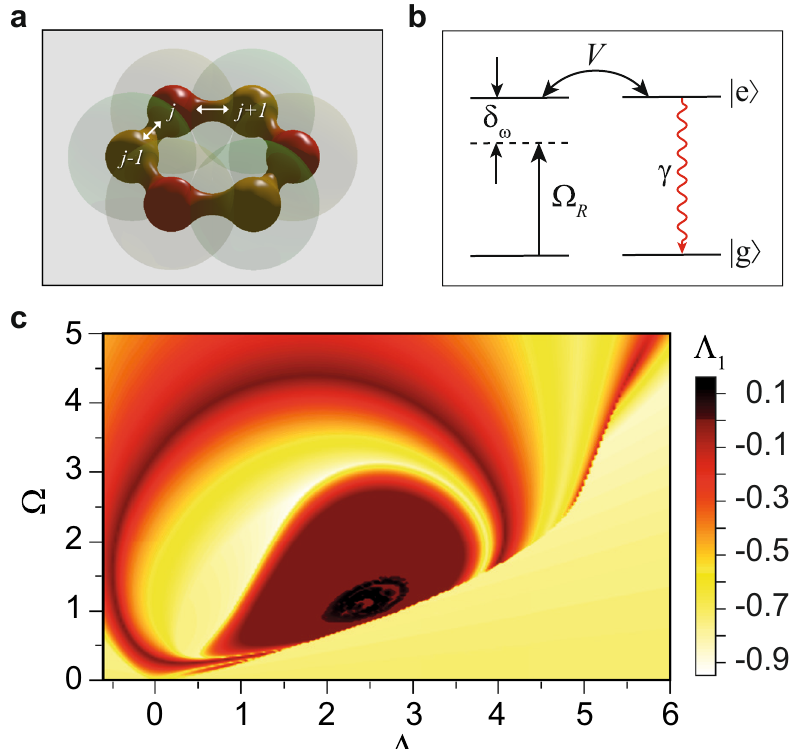
Fig. 1 Schematic representation of interacting qubits and the largest Lyapunov exponent dependence on model parameters for the case of two qubits. a Schematic representation of a circular chain of six interacting quantum units (e.g., Rydberg atoms or qubits), labeled by integer indexes and coupled via nearest neighbor interactions. b Atomic-level con fi guration re fl ected in the model [Eqs. (1) – (3)]. Coherent laser excitation from the ground state g j i to an excited ( “ Rydberg ” ) state e j i with a Rabi frequency Ω R and detuning δ ω , incoherent spontaneous decay γ , and the Rydberg interaction when an excited qubit shifts the transition frequency of a neighboring qubit by V . c Dependence of the largest Lyapunov exponent Λ 1 on Δ and Ω calculated for c = 5 for the system of 2 coupled qubits. The color scale intensity indicates the value of Λ 1